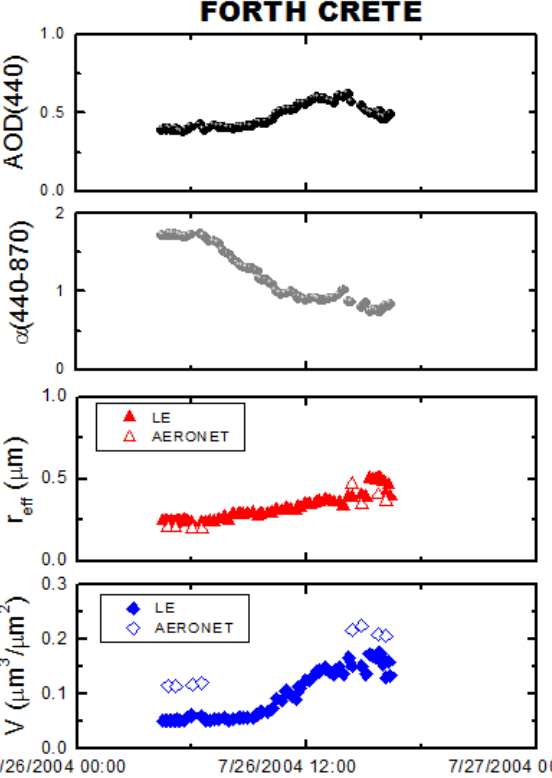
Figure 6. Time evolutions of aerosol optical depth (AOD(440)) and Ångström parameter ( α (440–870)) from AERONET Level 2.0 data at Solar Village on 6 July 2000. Also effective radius ( r eff ) and columnar volume aerosol content ( V ) are shown, both for opera- tional AERONET (open symbols) and linear estimation (full sym- bols) retrievals.